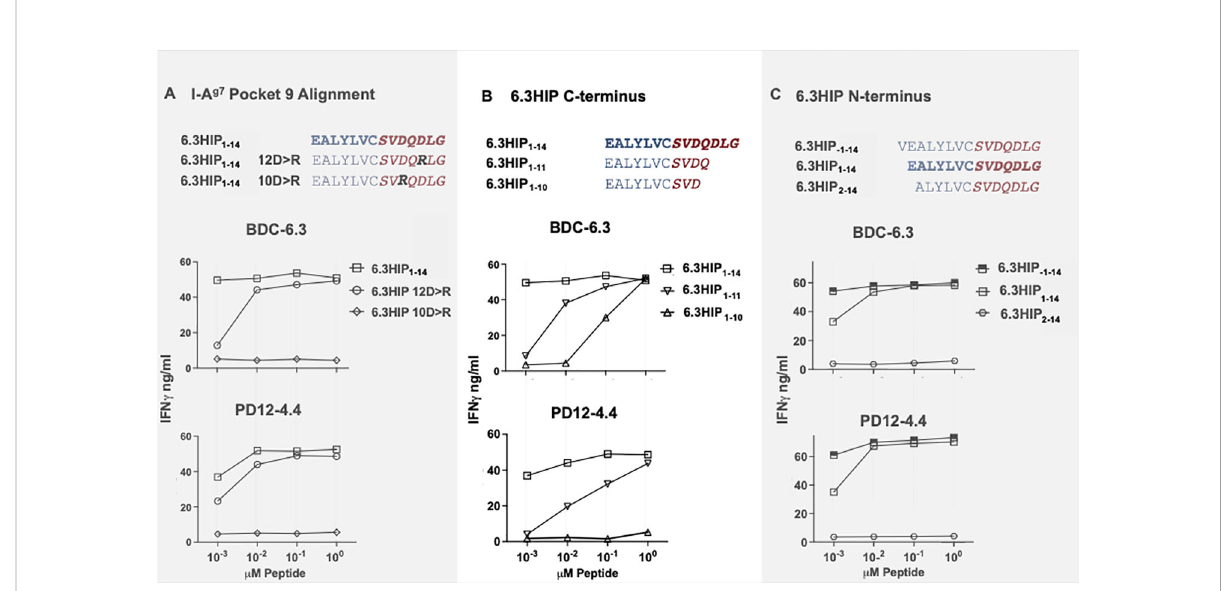
FIGURE 4 I-A g7 binding pocket 9 and optimal limits of the 6.3HIP antigen. (A) Determination of 6.3HIP residue occupying p9 of I-A g7 . IFN- g ELISA assays of T cell clones BDC-6.3 and PD12-4.4 stimulated with 6.3HIP 1-14 antigen compared to 6.3HIP substituted with 12D>R or 10D>R. (B) Response to C-terminal truncations of the 6.3HIP. IFN- g production by BDC-6.3 and PD12-4.4 in response antigens 6.3HIP, 6.3HIP 1-11 and 6.3HIP 1-10 . (C) Limits of the 6.3HIP epitope N-terminus. IFN- g production by BDC-6.3 and PD12-4.4 in response to peptides 6.3HIP. 6.3HIP -1-14 , and 6.3HIP 2-14 . Blue = B:9-23 sequence, red italics = ProSAAS sequence. Representative data from 4 experiments (A) , 6 experiments (B) , and 4 experiments (C) shown as ng/ml IFN- g